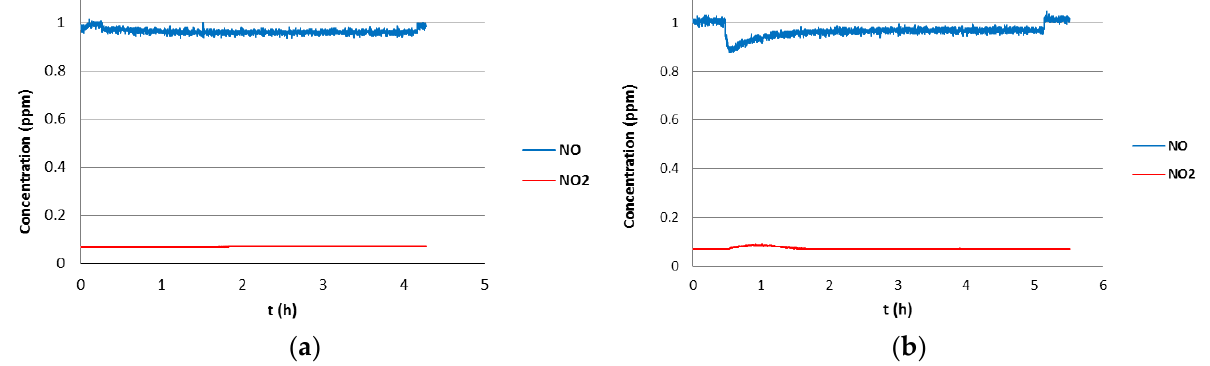
Figure 2. Photocatalytic activity in the degradation of NO(g) of coated-glasses fabricated from MLD Titanicone EG thin films (TiCl 4 /EG) after thermal treatment. ( a ) EG (1 s, 70 °C), thermal treatment: annealing at 400 °C for 2 h. ( b ) EG (4 s, 80 °C), thermal treatment: RT to 250 o C (1 min), 250 to 400 °C (90 min), 3 h at 450 °C (optimized annealing conditions).